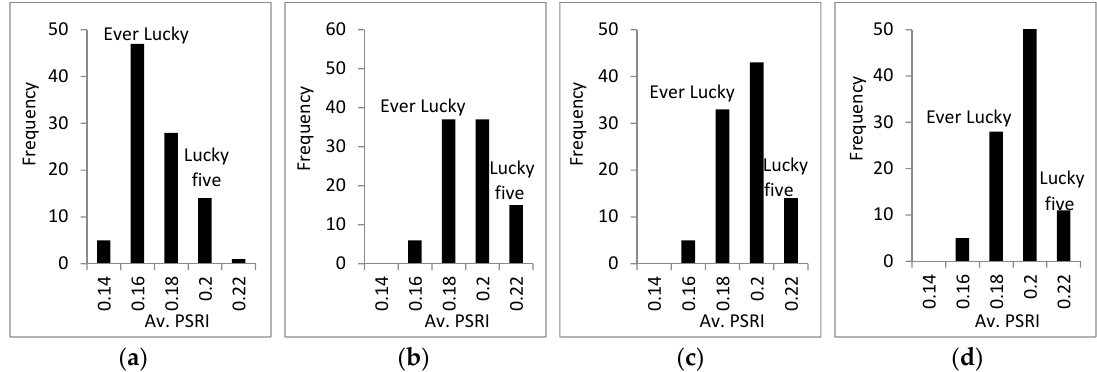
Figure 7. ( a ) Frequency distribution of average PSRI ( a ) before flooding, ( b ) during flooding, ( c ) during early recovery, and ( d ) during prolonged recovery. The commercial checks are attributed to their PSRI bin.